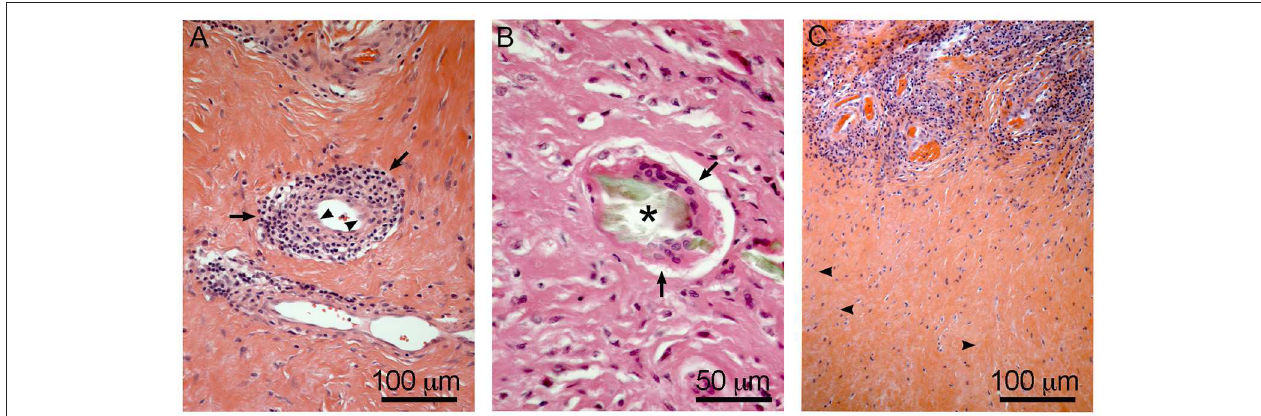
FIGURE 7 | Hypersensitivity features in ALTRs. Perivascular T cell infiltration/vasculitis (arrows) observed in (A) , note the changes in the morphology of the endothelial cells to rounded or prismatic (arrowheads). Giant multinucleated cell (arrows) in (B) , frequently they are associated with large corrosion-product (Cr rich, no Co) particles (asterisk). T cell infiltration zones are usually surrounded by necrotic areas with low vascularity and evidence of cell degeneration (arrowheads) (C)